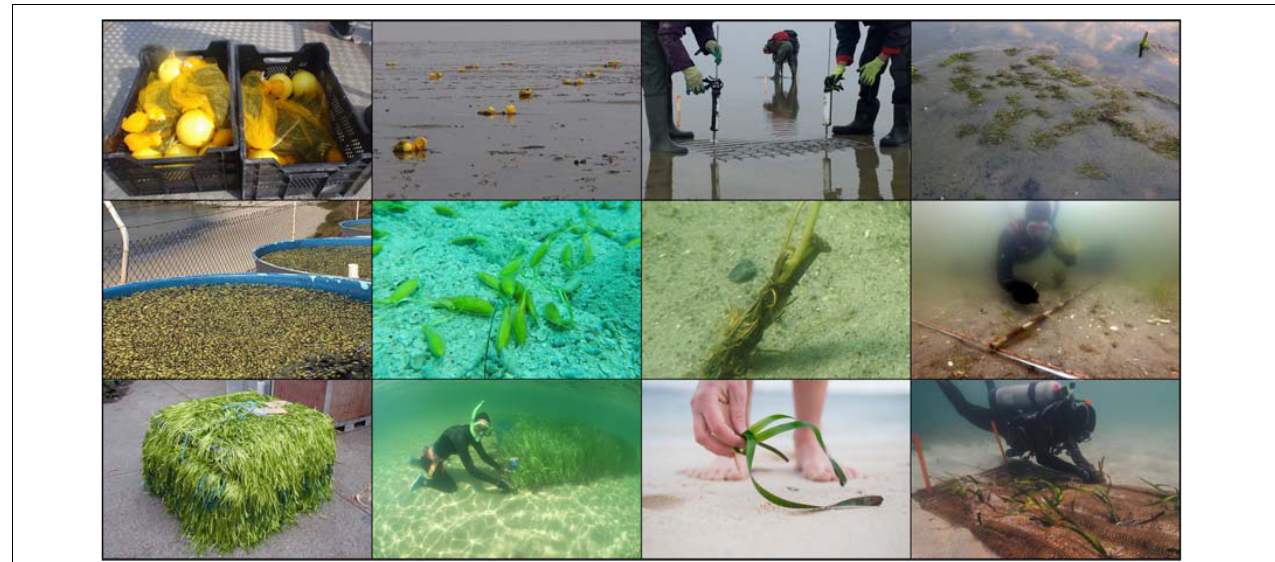
FIGURE 2 | Emerging tools and techniques developed within the international seagrass restoration community. First row left to right: buoy-deployed seeding (© Jannes Heusinkveld), Dispenser Injection Seeding (© Laura Govers). Second row left to right: seagrass nurseries (© Gary Kendrick and John Statton); anchoring shoots using iron nails (© Troels Lange). Third row left to right: artificial in-water structures (© Peter Macreadie), and collection and use of alternative sources of transplantation (© Harriet Spark).